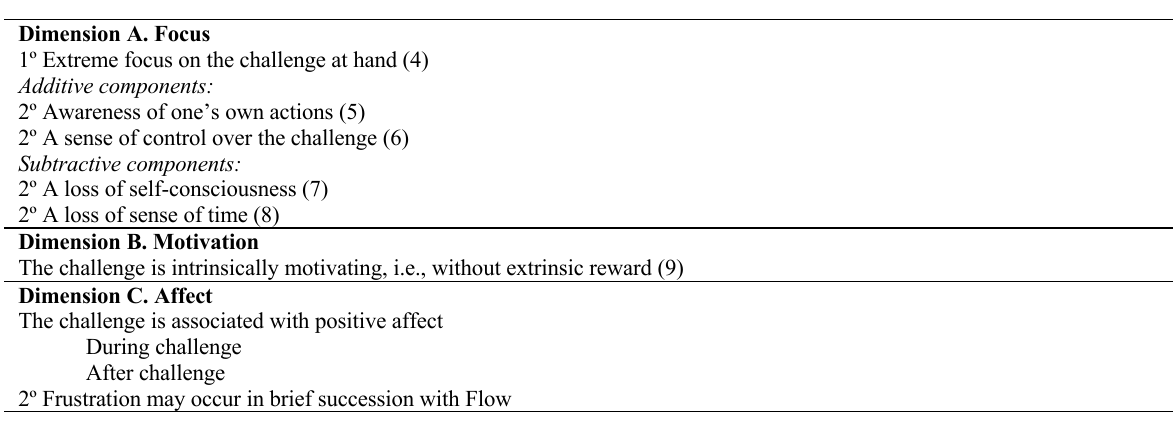
New Comparative Dimensions of Flow